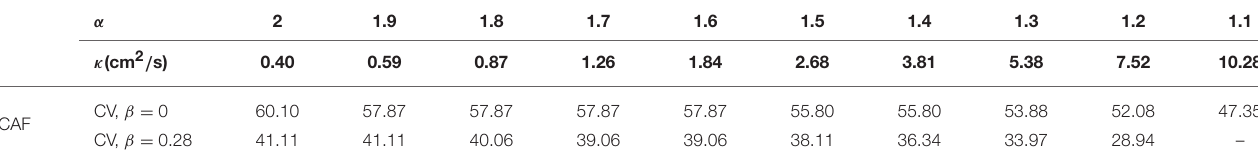
TABLE 1 | Adjusted values of κ that yield propagation at 63 cm / s under non-CAF conditions and β = 0. CV (cm / s) for CAF conditions with β = { 0,0.28 } . α